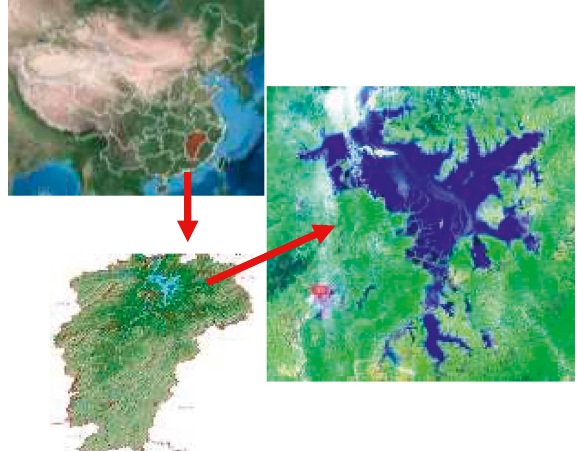
Figure 1: Geographical location of Poyang Lake.